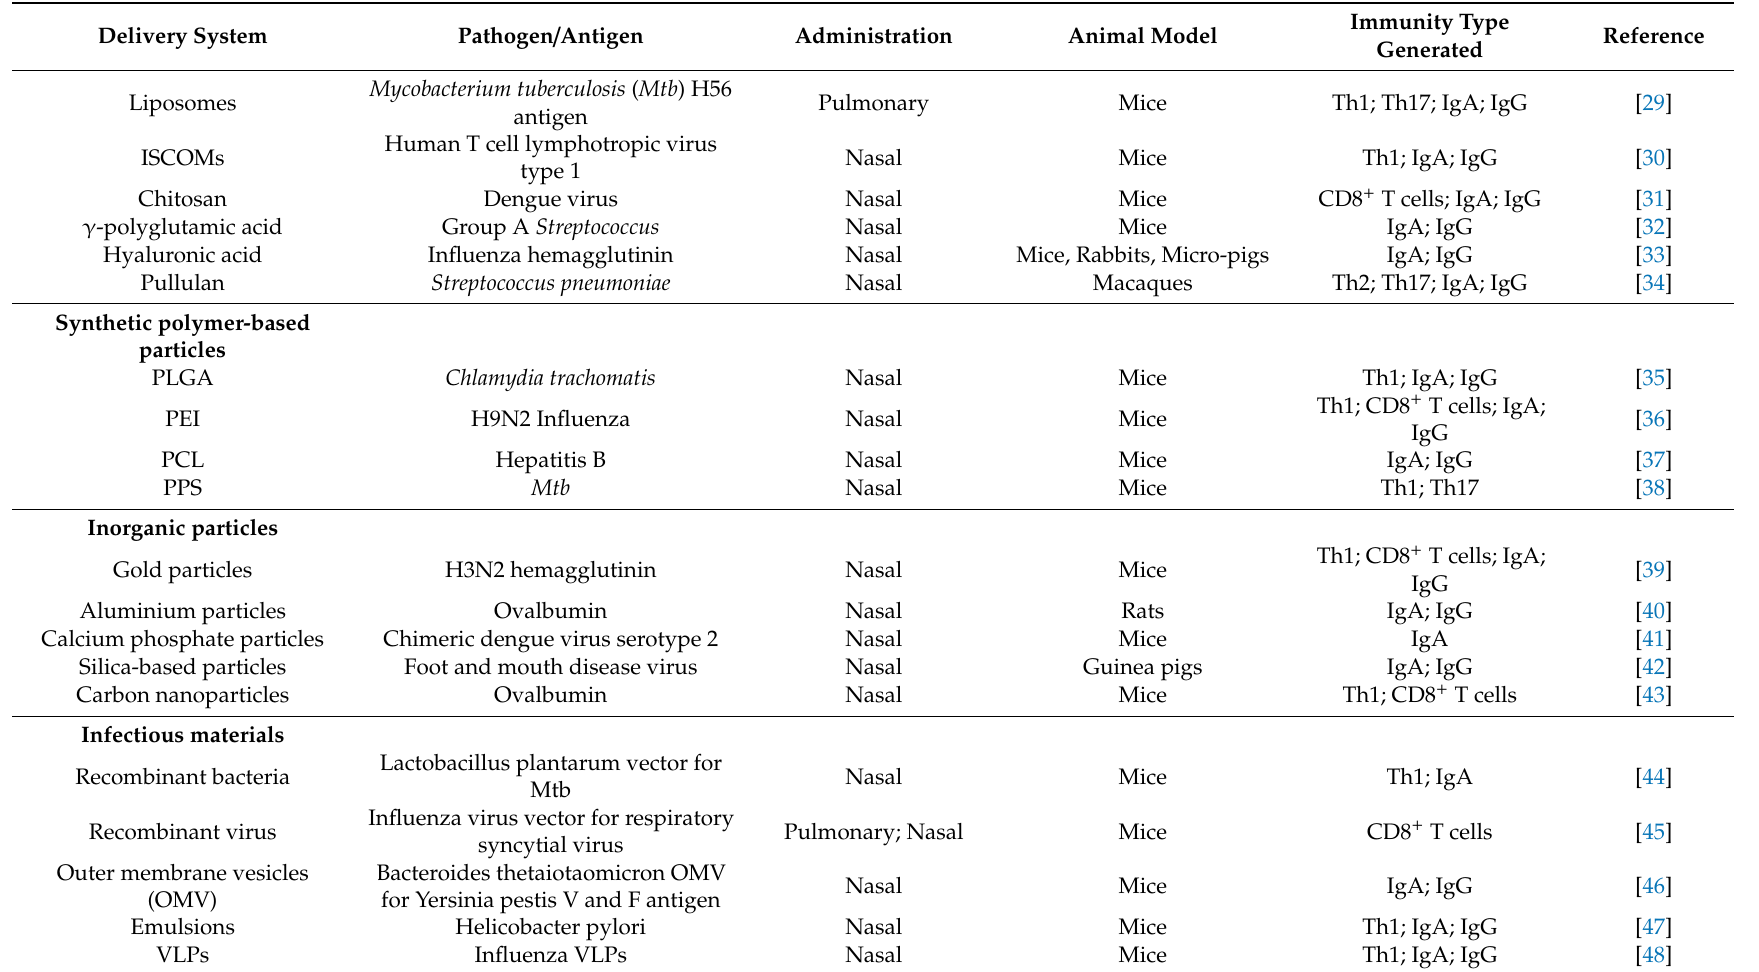
Table 2. Delivery systems for pulmonary and nasally delivered